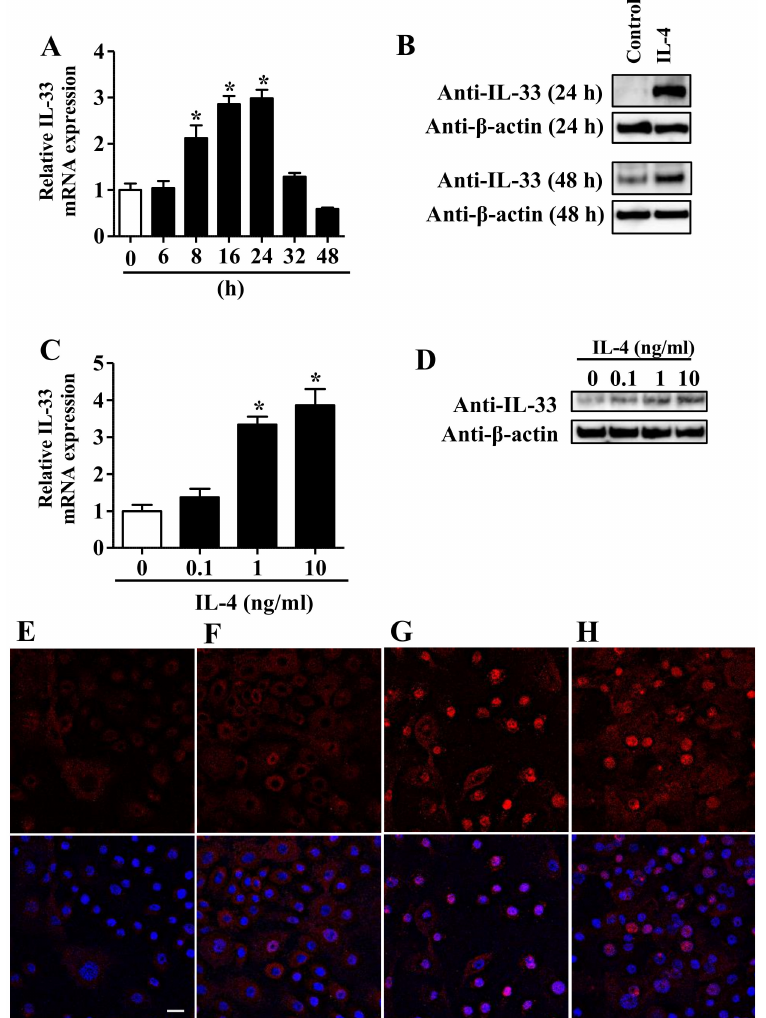
Figure 1. ( A , B ) Normal human epidermal keratinocytes (NHEKs) were treated with IL-4 (10 ng / mL) for the indicated period. ( C , D ) NHEKs were treated with IL-4 at the indicated dose for 24 h. ( A , C ) IL-33 expression was analyzed by qRT-PCR. Data are expressed as mean ± S.E.M.; n = 3 for each group. Statistically significant di ff erences between the expression of control and IL-4-treated NHEKs are presented: * p < 0.05. ( B , D ) Total cell lysates were prepared and subjected to Western blotting analysis with an anti-IL-33 antibody. The data are representative of experiments repeated three times with similar results. ( E ) Isotype negative control: The scale bar represents 25 µ m. NHEKs not treated with IL-4 ( F ), treated with IL-4 (10 ng / mL) for 8 h ( G ), or treated with IL-4 (10 ng / mL) for 24 h ( H ) were stained with an anti-IL-33 antibody (primary antibody) and an Alexa Fluor 546-conjugated anti-mouse IgG antibody (red: secondary antibody). DAPI (4 (cid:48) ,6-diamidino-2-phenylindole) was utilized for nuclear staining. Confocal laser scanning images revealed increased nuclear IL-33 expression (red) in IL-4-treated NHEKs compared with that in phosphate-bu ff ered saline (PBS)-treated NHEKs. The data are representative of experiments repeated three times with similar